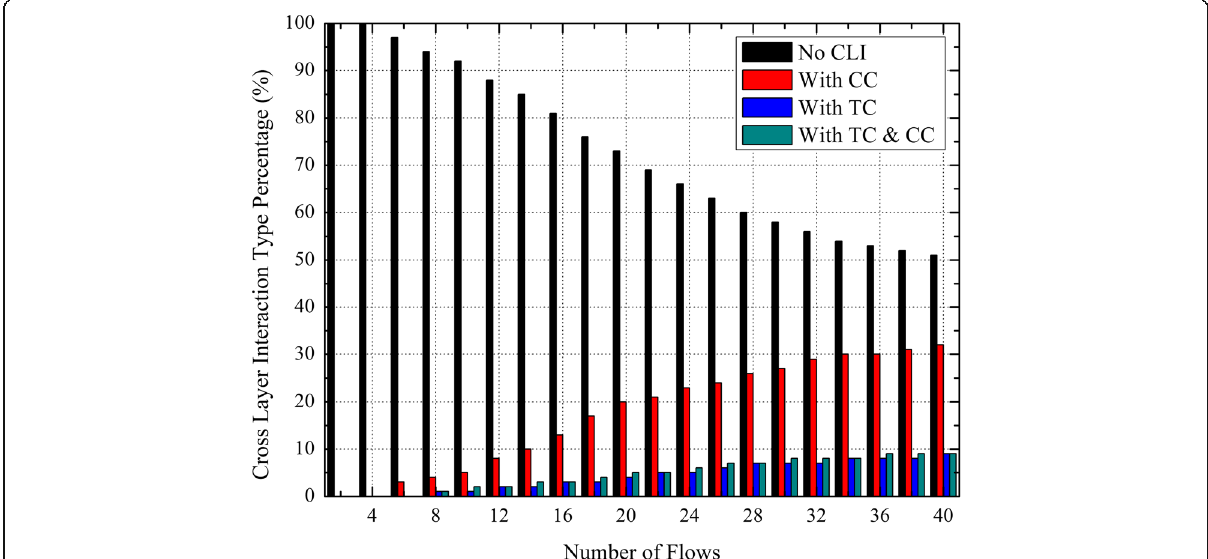
Fig. 31 Cross layer interaction type percentage of NAER under different number of flows in random network. Figure 31 shows the cross layer interaction type percentage comparison of NAER under different number of flows in random